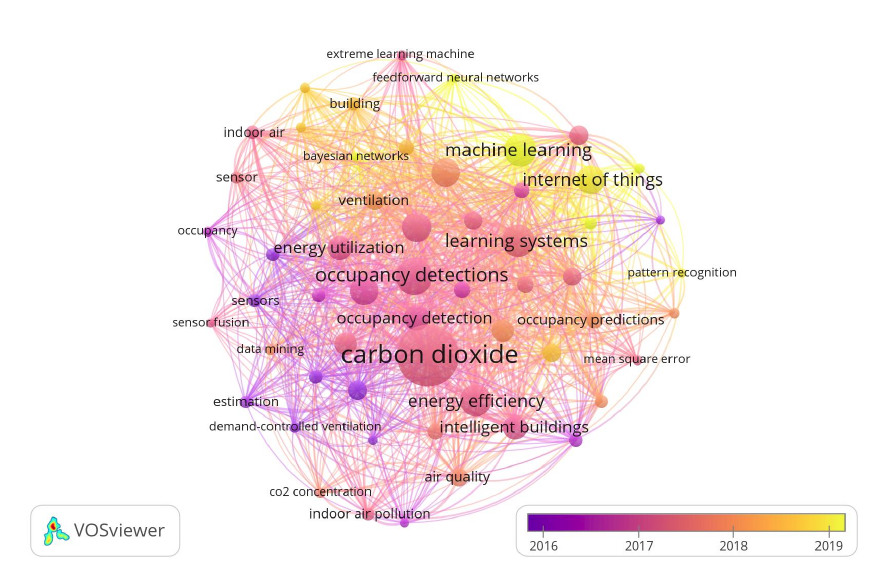
Figure 8. The most relevant keywords of the selected publications.